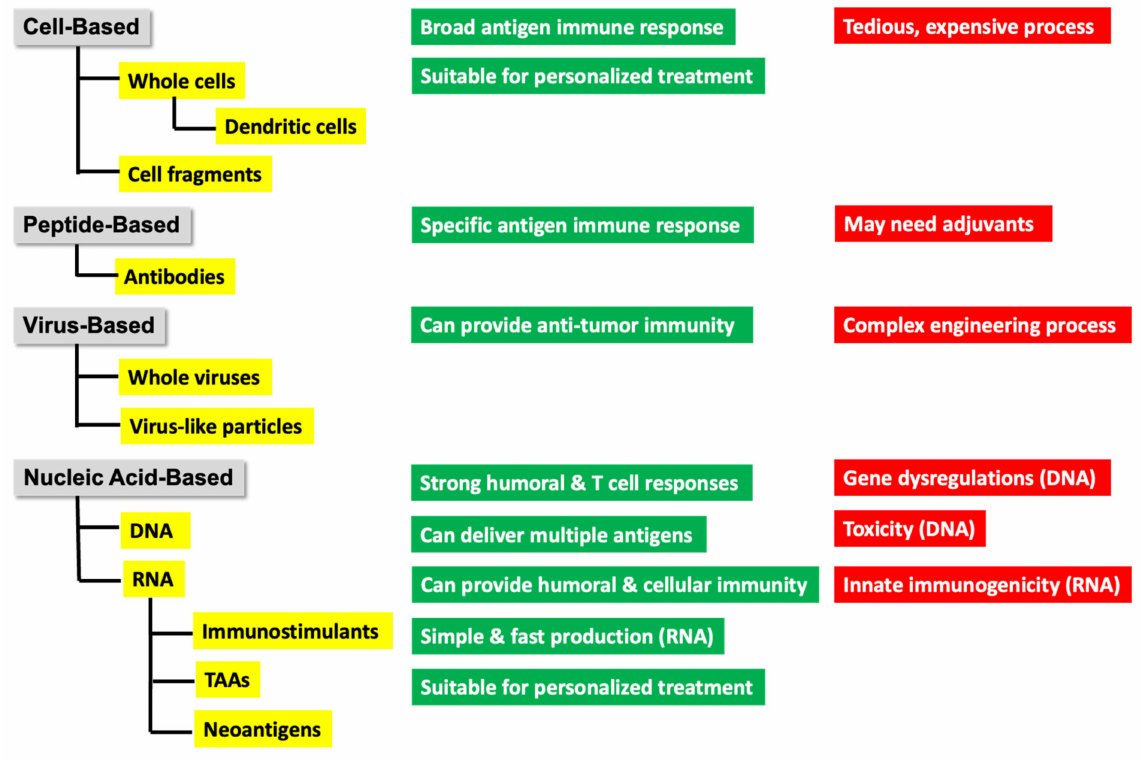
Figure 3. Major types of cancer immunotherapy with their benefits in green and their downsides in red. Cancer immunotherapeutics may be divided into four categories: use of recombinant viruses, tumor and immune cell (mainly dendritic cells)-constructed immunizations, and peptide and nucleic acid-based (DNA or RNA) vaccines [41,98] as illustrated in Figure